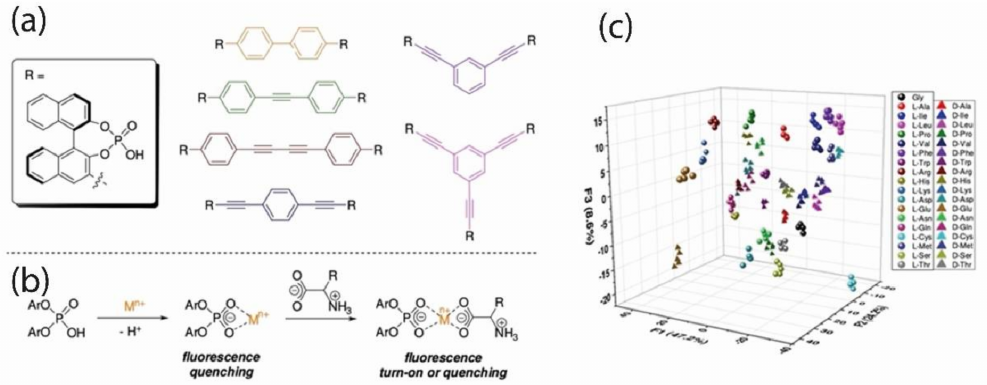
Figure 8. ( a ) Structures of the chiral fluorescent phosphoric acids, ( b ) sensing mechanism, and ( c ) LDA score plots for 36 amino acid enantiomers discrimination made by Niemeyer et al. Adapted from Ref. [40] with permission from Wiley, copyright